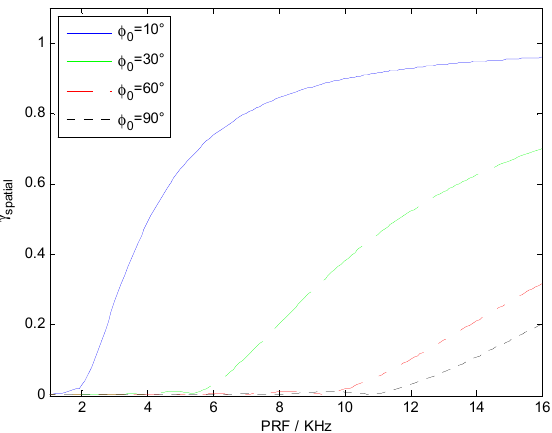
Figure 11. The relationship between the pulse repetition frequency (PRF) and spatial decorrelation in different observation azimuths.